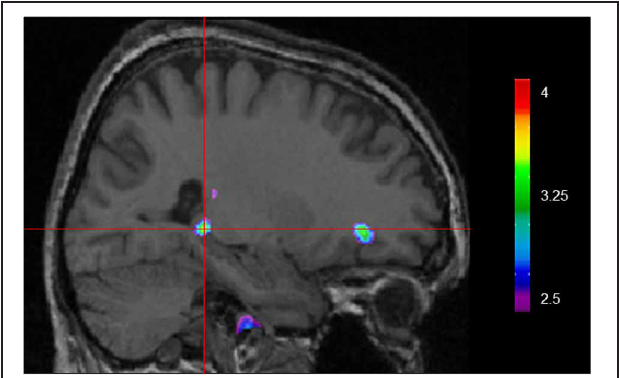
FIGURE 2 | Whole brain regression analysis with scores on recombined pairs condition of CSDLT (Stage 2). Results are superimposed onto an anatomical MRI and displayed in the sagittal plane. Results show that gray matter in the hippocampus significantly co-vary with spatial navigational